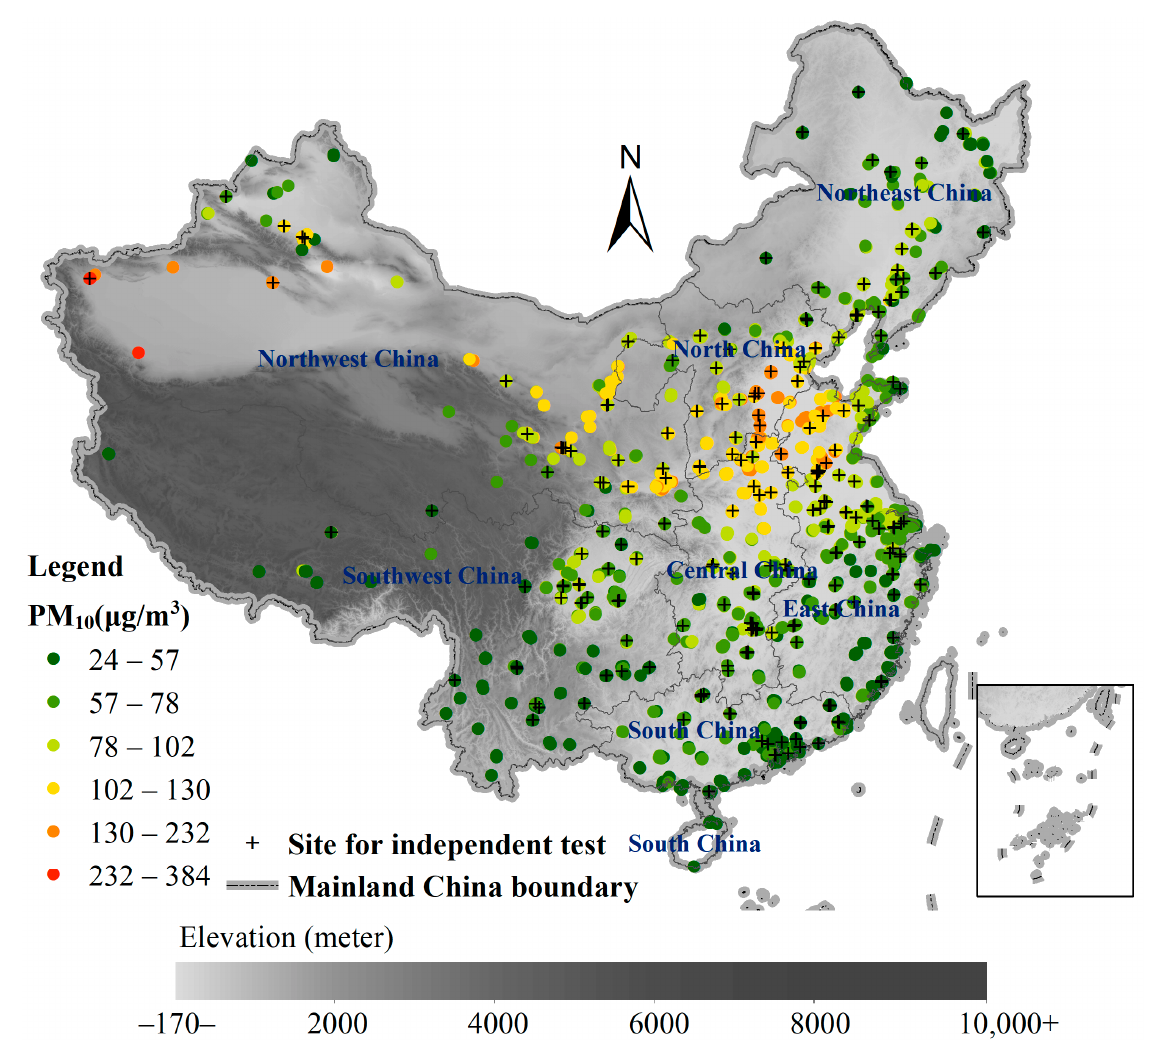
Figure 1. The study region of mainland China with seven geographic regions, and the PM monitoring sites and those selected for the site-based independent